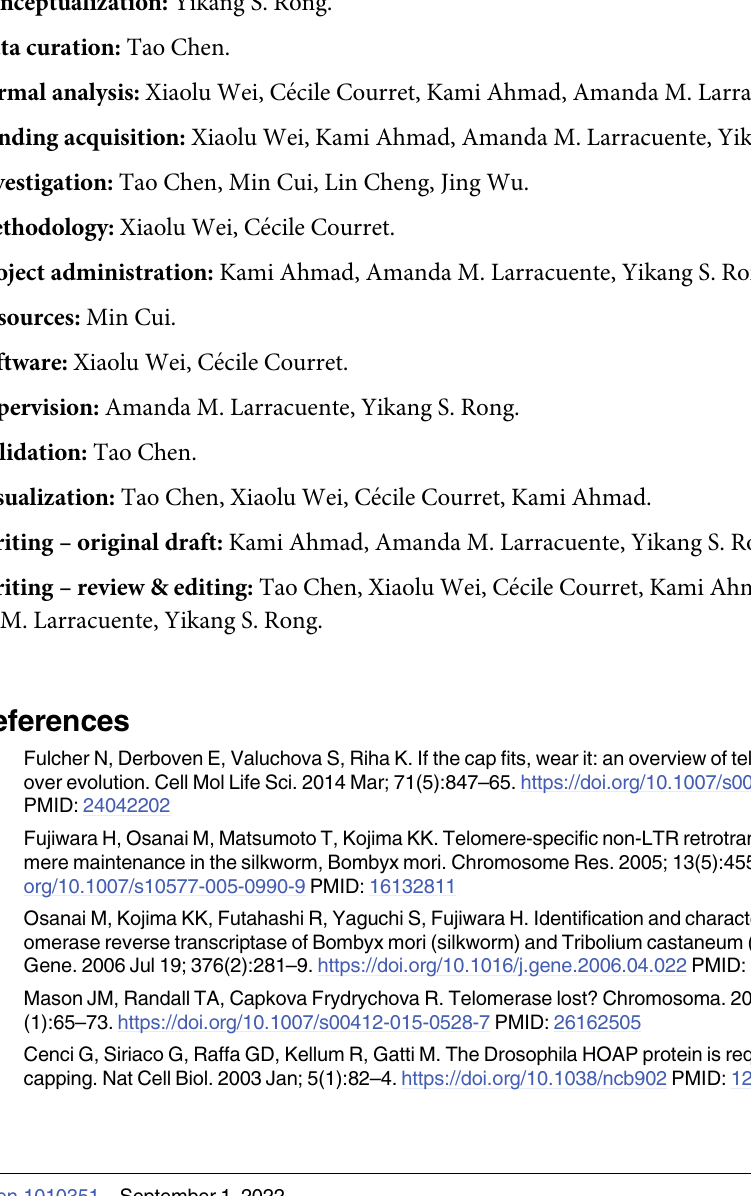
S8 Table. Enrichment scores for simple repeats. Normalized enrichment scores of the target protein over no-tag control (in RPM) for the simple tandem repeats enriched in HipHop and HOAP. S1 Protocol. A detailed protocol for nanoCUT&RUN. S2 Protocol. A detailed protocol for nGFPMNase